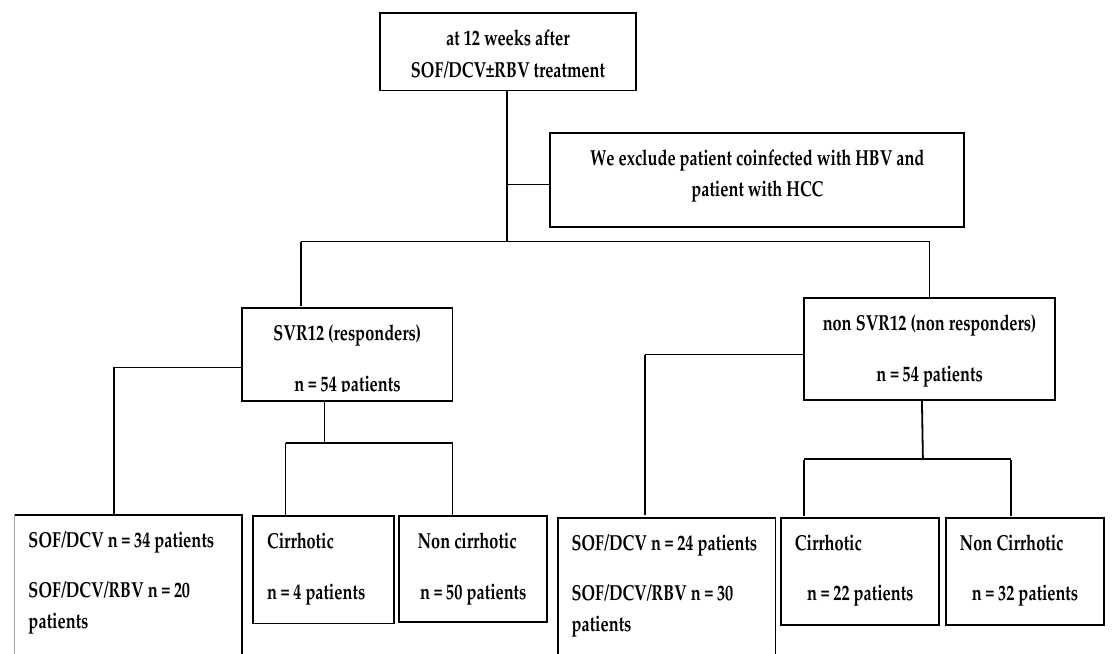
Figure 1. The patients enrolled in the study through the clinical.